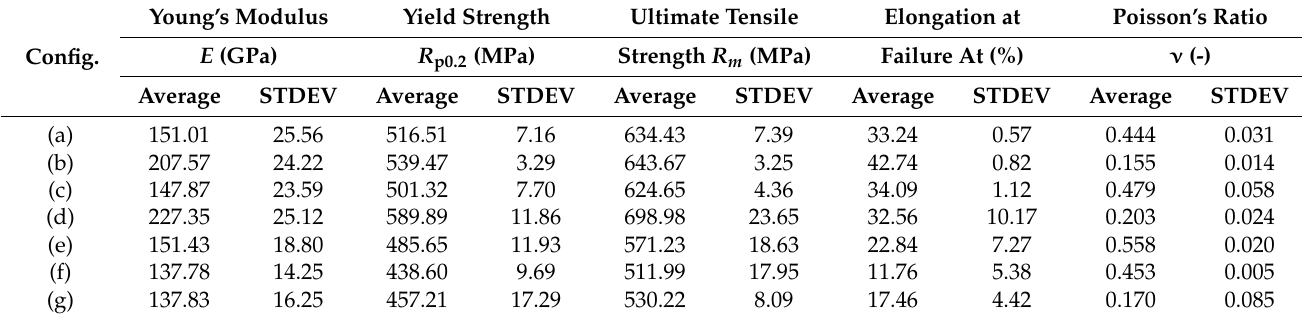
Table 12. The tensile properties of 1.4404 (316L) in different building configurations. See also Table 11 and Figure 7. The specimens were built with an oversize of 0.4 mm in width and thickness and milled to final shape before tensile testing. The table is from